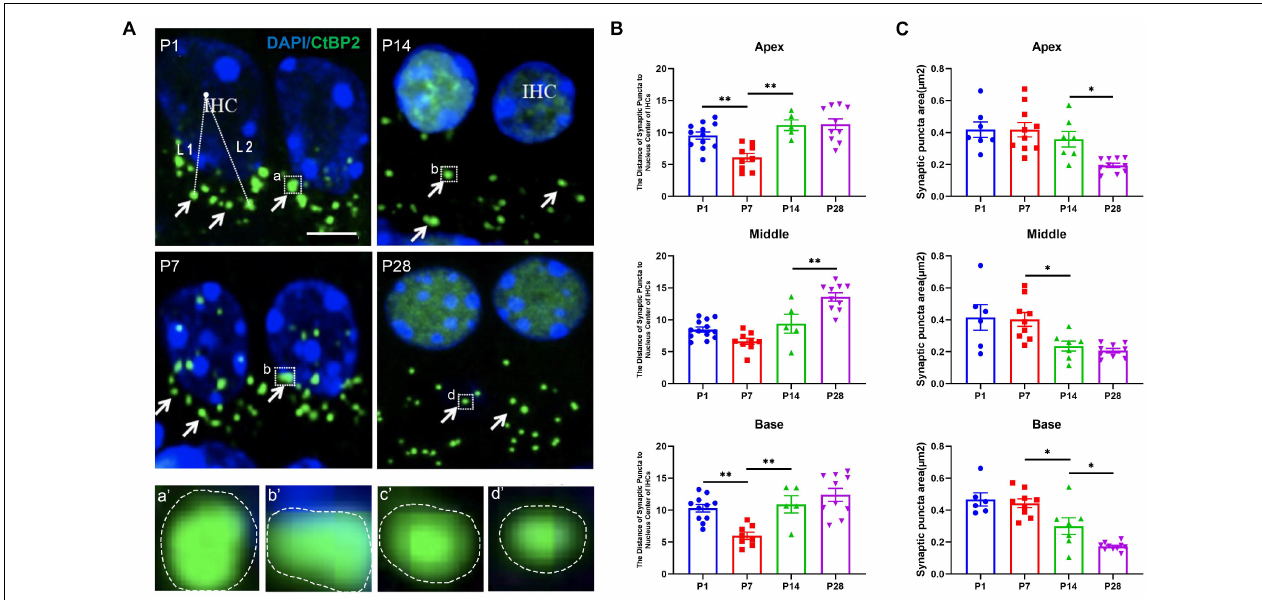
FIGURE 3 | Calculation of the size of synaptic spots and the distance between synaptic puncta and the nucleic center in adjacent IHCs. (A) DAPI staining of the nuclei of IHCs (blue) and ribbon synaptic puncta was performed using anti-CtBP2 (green, white indicated). The white dashed line indicates the distance from the synaptic puncta to the nucleic center of the adjacent IHC (L1, L2); (a–d) represent different sizes of synaptic puncta at P1, P7, P14, and P28 (white dashed frame); (a (cid:48) –d (cid:48) ) are enlarged images of panels (a–d) , respectively. Scale bar = 5 µ m. (B) Quantitative analysis of the distance between synaptic puncta and the nucleic center of adjacent IHCs. Compared with P1, a significantly increased distance was observed at P14 and P28 (** p < 0.01, apical and basal), and a more significantly enhanced distance appeared at P28 (** p < 0.01, middle). (C) Quantitative analysis of synaptic spot size. The sizes of the synaptic puncta at P1 and P7 were significantly larger than those at P14 and P28 (* p < 0.05, middle and basal); at the apex, the sizes at P1, P7, and P14 were significantly larger than those at P28 (* p < 0.05, apex). IHC, inner hair